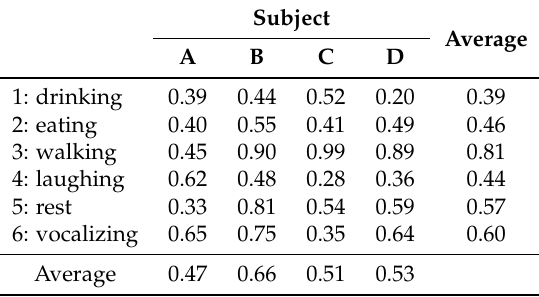
Table 4. Precision of each behavior for all